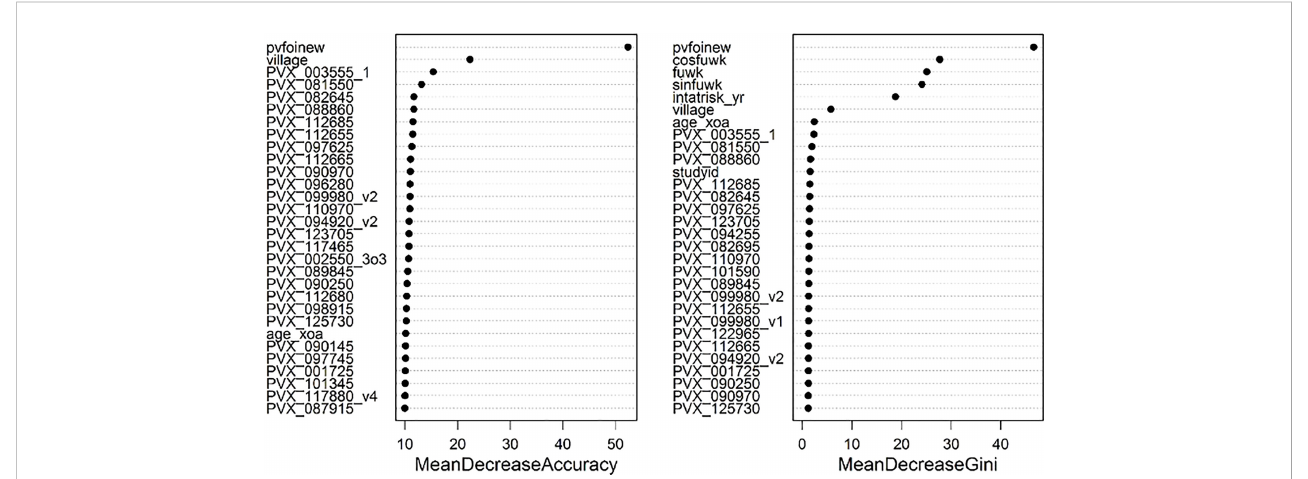
FIGURE 3 Variable importance plots from the Random Forests algorithm. Two measures of importance are given for each variable. The mean decrease in accuracy is based on how much the accuracy decreases when the variable is excluded. The second measure is based on the decrease of Gini impurity when a variable is chosen to split a node in a decision tree of the random forest. Higher ranking variables indicate a greater contribution to classi fi cation performance, i.e. between children with and without clinical P. vivax infections.